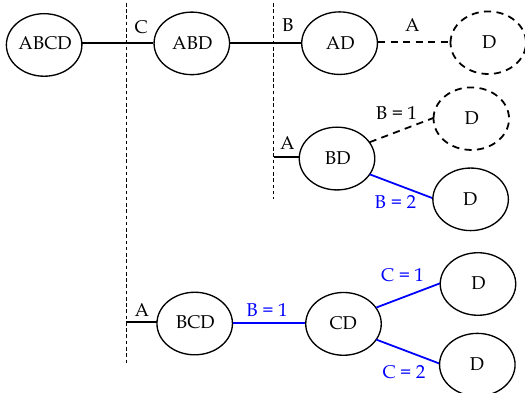
Figure A33. Tree graph for the analysis of the effect of factor D on the convergence performance. Dashed nodes and arcs correspond to rejected conclusions due to multimodal population. Arcs in blue denote decisions on the value of factors based on forced interactions.